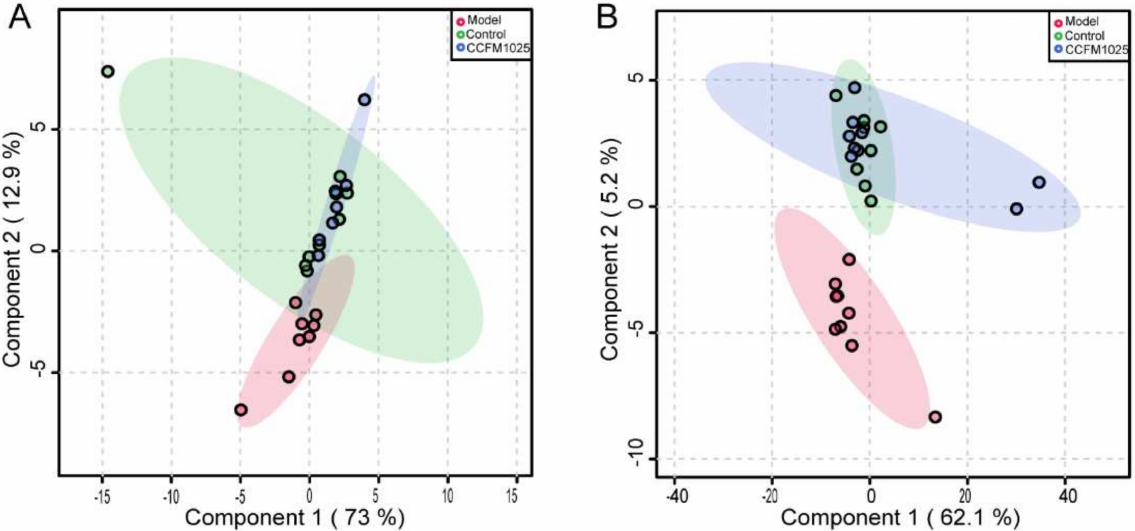
Figure 2. PLS-DA score plot for serum ( A ) and hippocampus ( B ) samples among all groups. PLS-DA: partial least squares discrimination analysis.